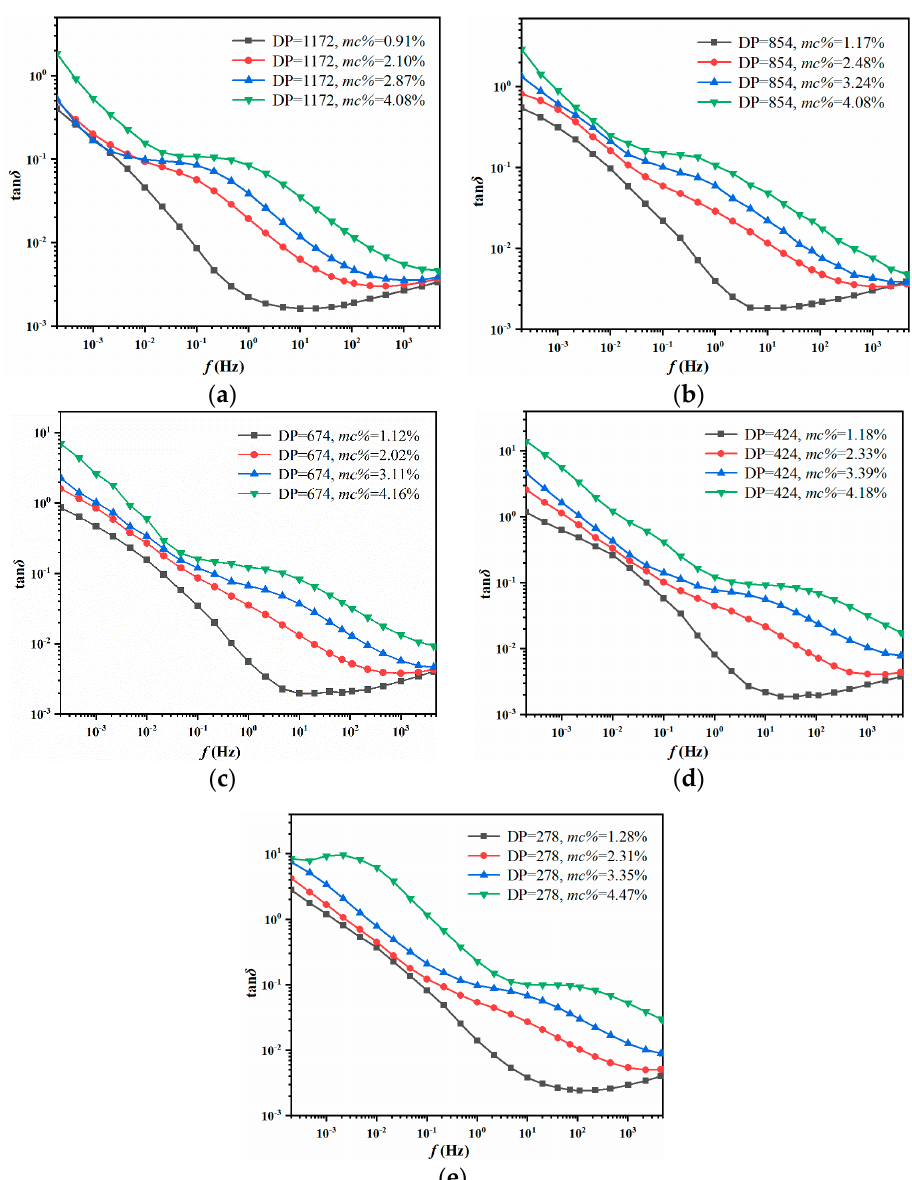
Figure 2. Tan δ curves of prepared samples. ( a ) Aged 0 day; ( b ) Aged 1 day; ( c ) Aged 3 days; ( d ) Aged 7 days; and ( e ) Aged 14 days. Table 3. Dielectric fingerprints ( D 1 – D 4 ) of prepared oil-immersed pressboards.